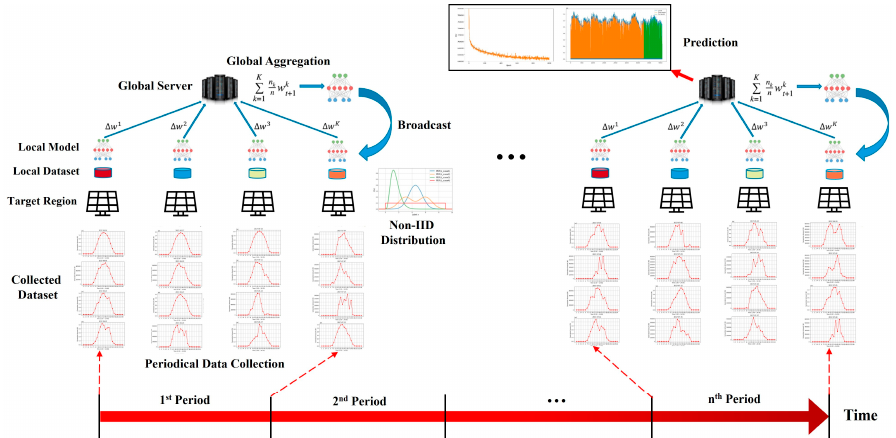
Figure 1. Federated Learning architecture visualization in solar energy generation environment.